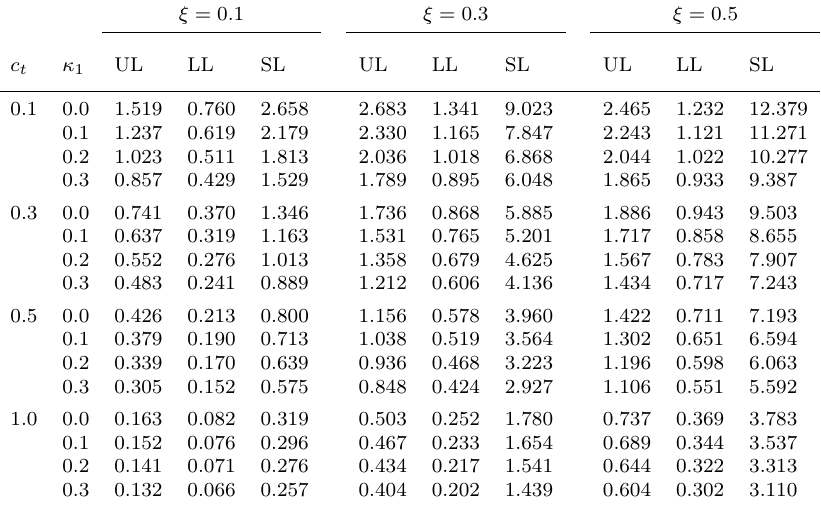
Table 1. Effect of the nonlocal parameter ξ , the viscous damping coefficient c t and the Winkler’s parameter κ 1 on the angular displacement ¯ v of C-C CNTs under different load ( L = 11 nm). ξ = 0 . 1 ξ = 0 . 3 ξ = 0 .